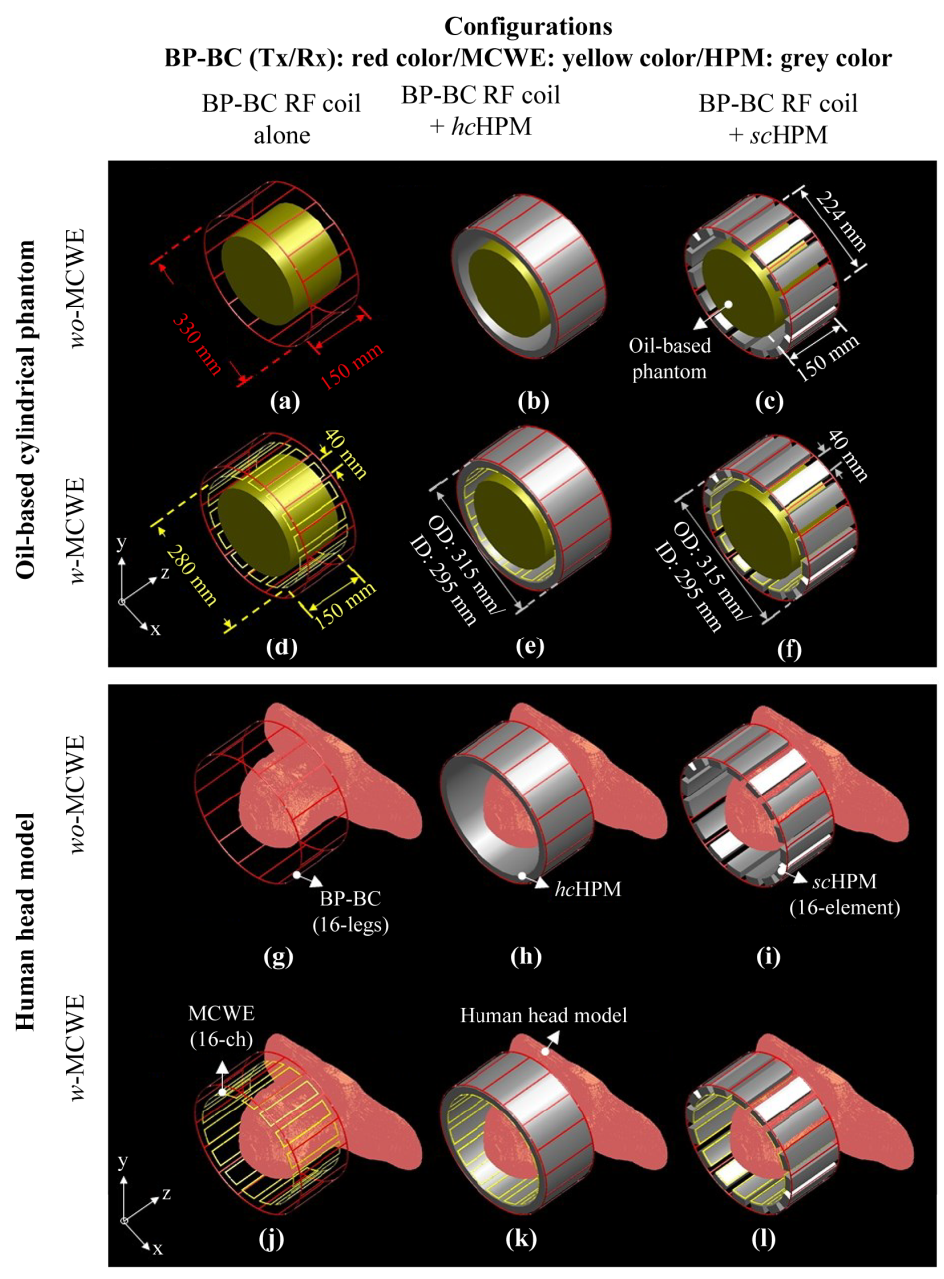
Figure 1. Configurations of BP-BC, MCWE, and HPM for EM-field simulations using oil-based cylindrical phantom ( a – f ) or human body model ( g – l ): ( a , g ) BP-BC RF coil alone − wo -MCWE; ( b , h ) BP-BC RF coil + hc HPM − wo -MCWE; ( c , i ) BP-BC RF coil + sc HPM − wo -MCWE; ( d , j ) BP-BC RF coil alone − w -MCWE; ( e , k ) BP-BC RF coil + hc HPM − w -MCWE; ( f , l ) BP-BC RF coil + sc HPM − w Table 1. The maximum values of EM-field simulation results (| B (cid:2869) |-, | B (cid:2869)(cid:2878) |-, | B (cid:2869)(cid:2879) |-, and |E|-field) using oil-based cylindrical phantom and human head model.